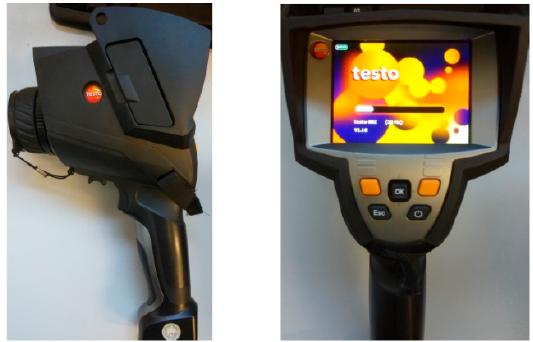
Figure 2. IR camera Testo 882 to measure surface temperature variation used during fatigue tests.